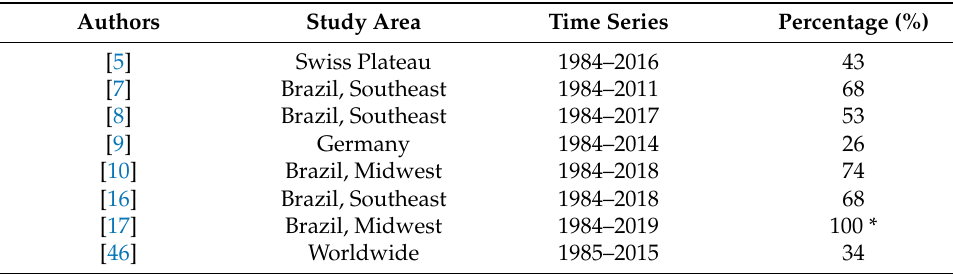
Table 4. A list of some studies used the SySI